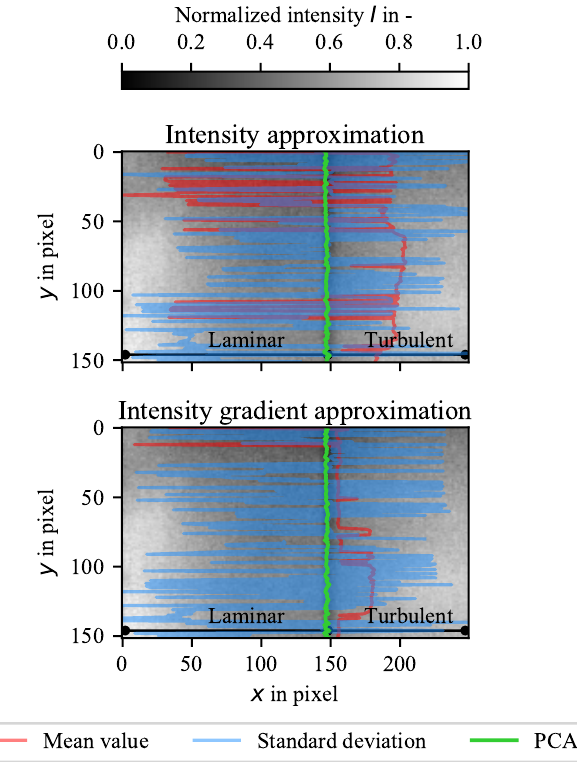
Figure 10. Comparison of the located laminar turbulent flow transition line by means of the temporal mean value (red), temporal standard deviation (blue) and PCA (green) flow visualization of the image series. Flow transition localization based on the approximation of the intensity profile (top) and approximation of the intensity gradient profile (bottom). For both methods, the localization in the PCA result has qualitatively the lowest random and systematic